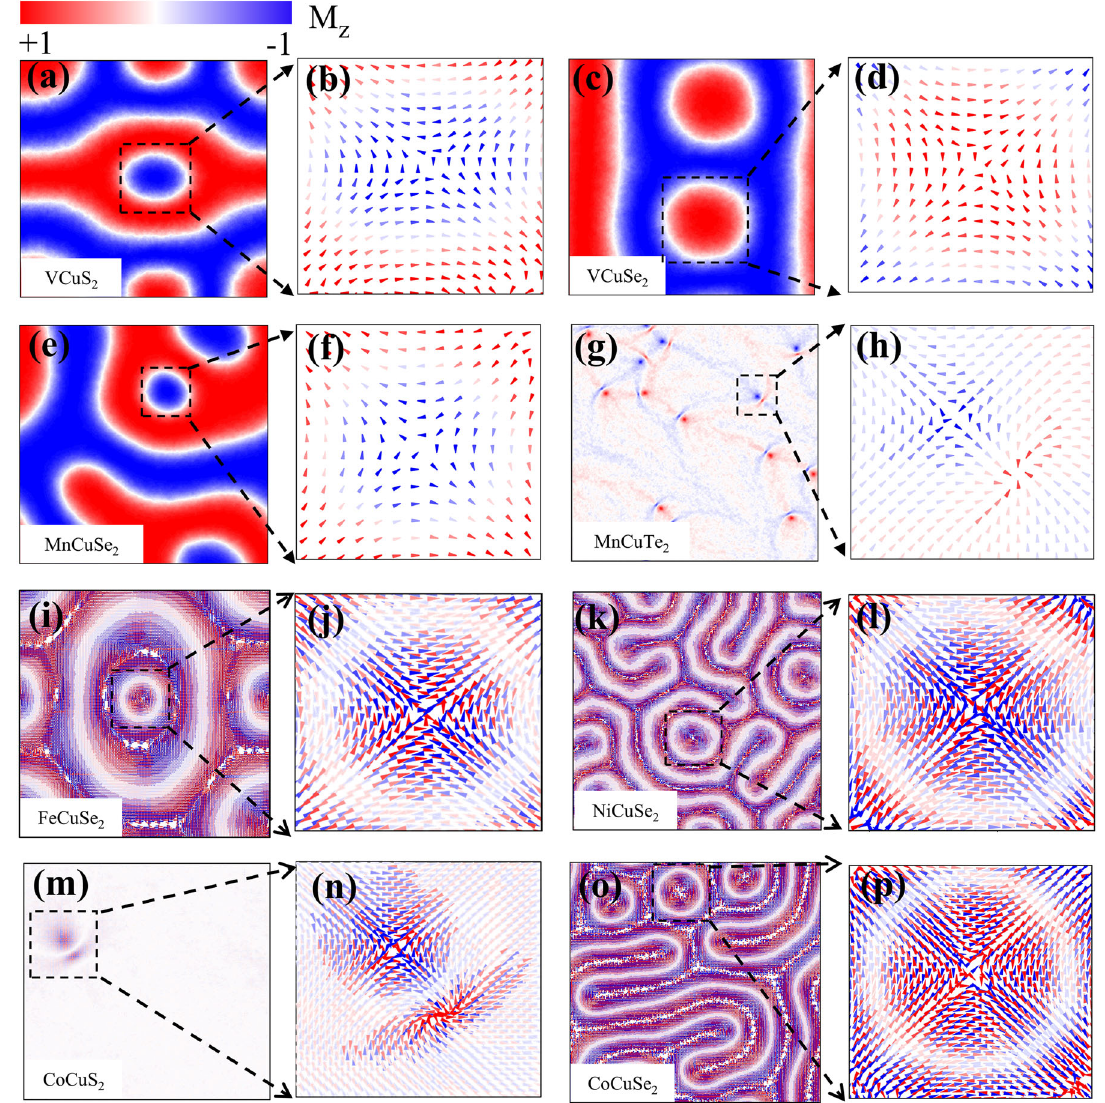
Fig. 4 Spin con fi gurations of ground states of monolayers M Cu X 2 in real-space. Spin con fi guration of a 100 nm × 100 nm square and zoom of isolated chiral magnetic pro fi le of VCuS 2 ( a , b ); VCuSe 2 ( c , d ); MnCuS 2 ( e , f ); MnCuTe 2 ( g , h ); FeCuSe 2 ( i , j ); NiCuSe 2 ( k , l ); CoCuS 2 ( m , n ) and CoCuSe 2 ( o , p ). The color map indicates the out-of-plane spin